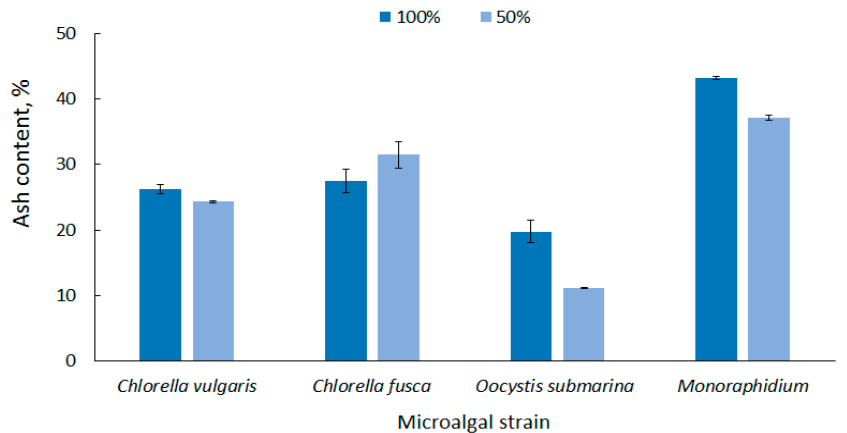
Figure 3. Ash content in microalgal biomass under nutrient limitation.